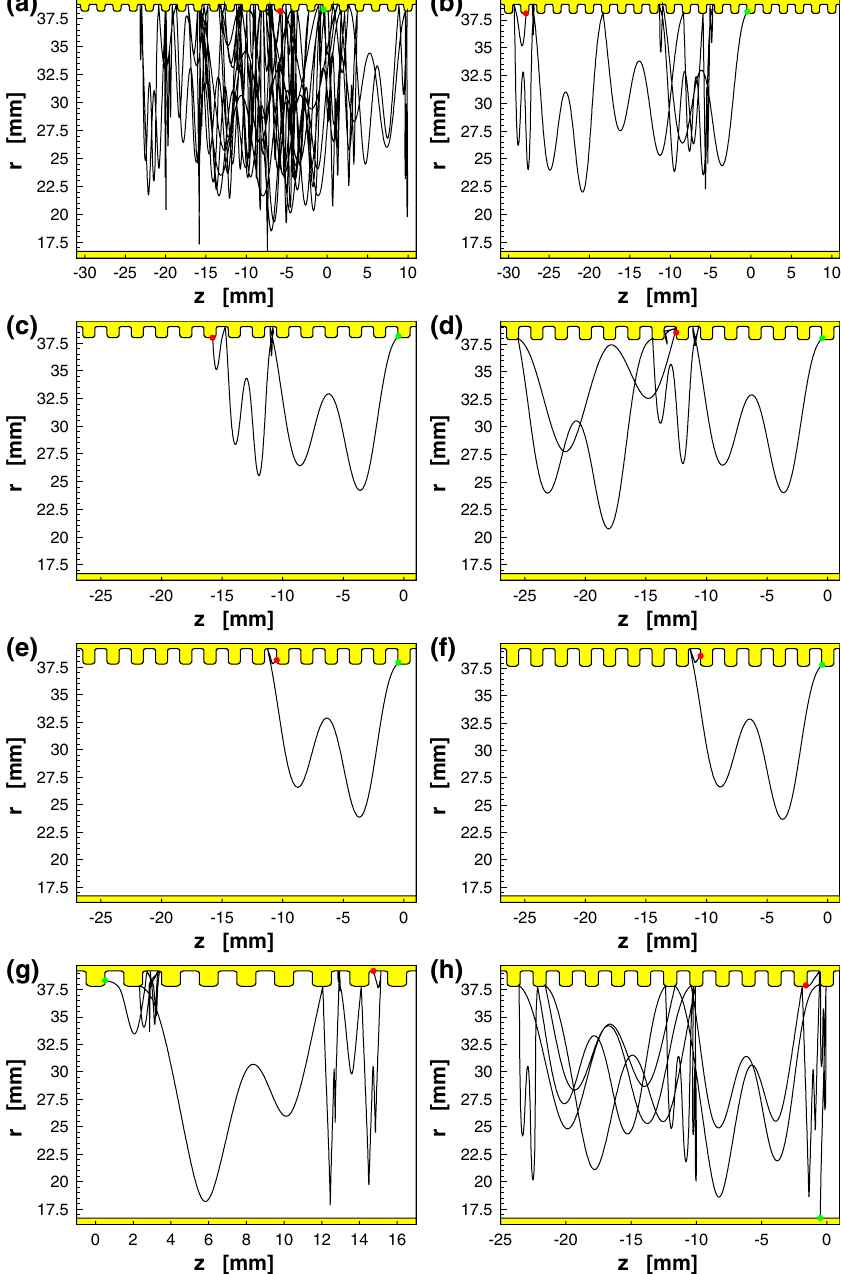
¼ 390 kW , (cid:1) ¼ 0 , and a pitch of 2.0 mm. For depths: FIG. 7. Examples of multipactoring-electron trajectories in the case of P in ¼ 4 : 398 rad and the same initial position. For (a) 0.6 mm, (b) 0.8 mm, (c) 1.0 mm, (d) 1.2 mm, (e) 1.4 mm, and (f) 1.6 mm for (cid:3) ð I Þ 0 ¼ 4 : 021 rad and (h) (cid:3) ð I Þ ¼ 1 : 885 rad for a depth of 1.4 mm. The green dots indicate the starting points, and the red dots (g) (cid:3) ð I Þ 0 0 ¼ 100 eV . Defining a indicate the ending points, where all the impact energies at the last impact in these examples are lower than E min , the (cid:4) ( N ) values are 1.60 (65), 1.48 (12), 1.16 (5), 1.49 (7), 1.31 (2), multipactoring order ( (cid:4) ) as ð simulated time Þ (cid:2) != ð 2 (cid:2) Þ =N imp imp 1.38 (2), 1.26 (11), and 1.77 (13) for (a), (b), (c), (d), (e), (f), (g), and (h),